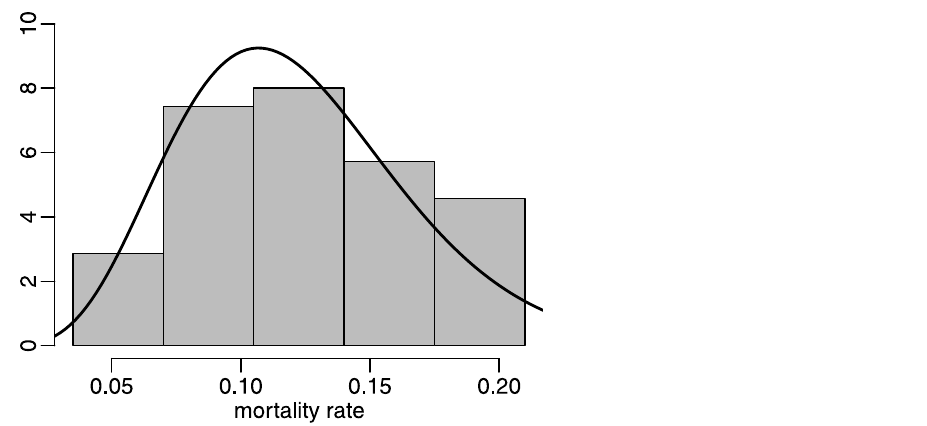
Fig 8. Histogram and fitted beta density, period